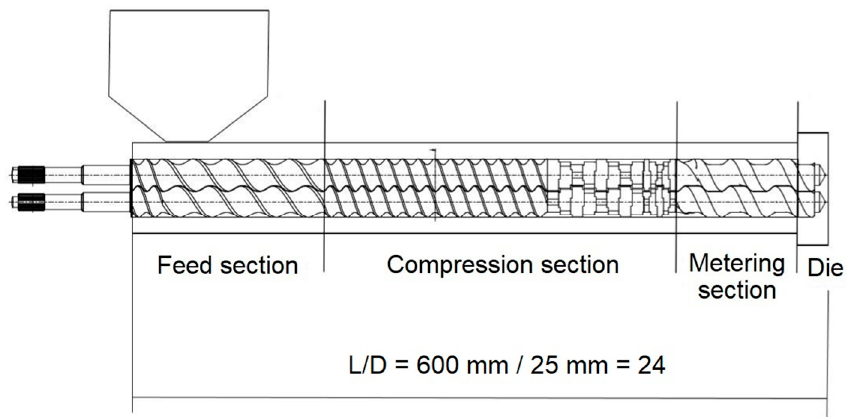
Figure 2. Twin-screw co-rotating extruder and its screw configuration.